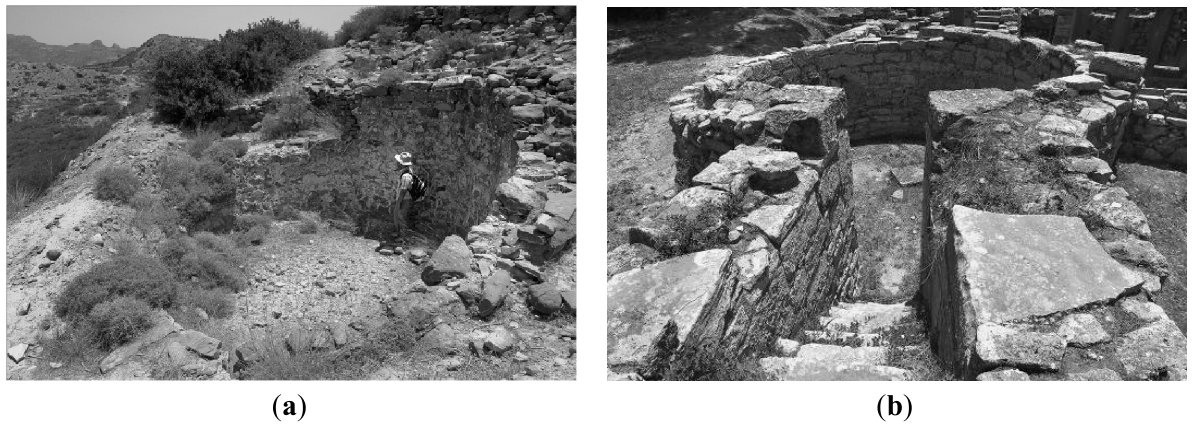
Figure 3. Minoan cisterns: at Myrtos-Pyrgos in the S.E. Crete ( a ) and at Tylissos Houses ( b